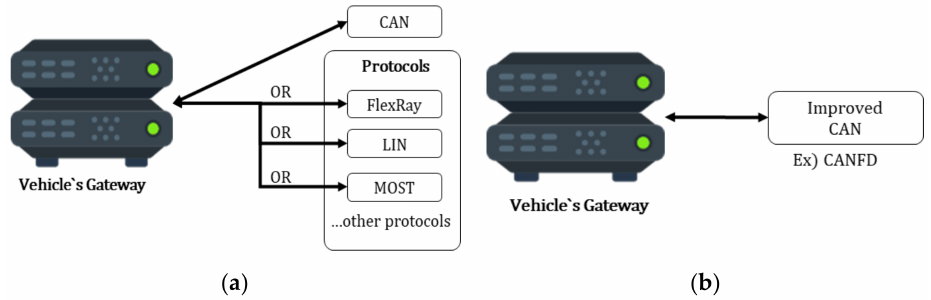
Figure 1. Controller Area Network (CAN) protocol. ( a ) CAN protocol; ( b ) Improved CAN